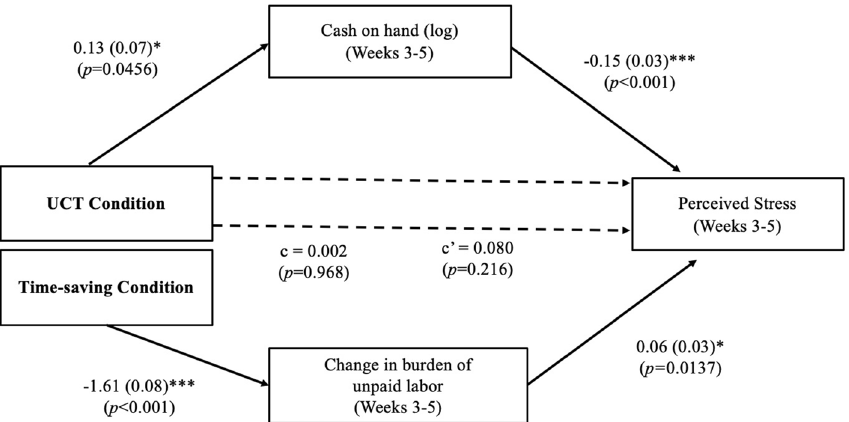
Figure 2. Parallel mediation analysis. Mediating effects of changes in perceived burden of unpaid labor and (log) cash on hand. Reported are standardized coefficients, controlling for baseline perceived stress and baseline income. Cash on hand (log), change in burden of unpaid labor, and total spending (log) during the treatment weeks were analyzed as parallel mediators. The indirect effect of cash on hand (log) was significant, indirect effect = 0.02 (0.01), 95% CI [0.004, 0.04]. The indirect effect of the change in burden of unpaid labor was significant, indirect effect = − 0.10 (0.04), 95% CI [− 0.19, − 0.02]. The indirect effect of total spending (log) was not significant, indirect effect = 0.001 (0.004), 95% CI [− 0.005, 0.010]. The total effects of conditions (time- saving = 1, UCT = 0) are reported as c ; direct effects are reported as c’ . See Table S9a for further detail. * p < 0.05, ** p < 0.01, *** p <